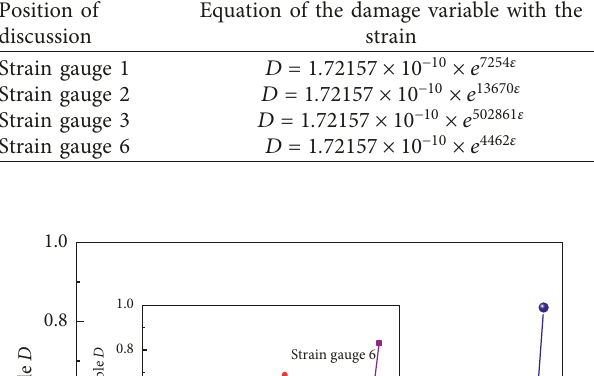
Table 3: Basic physical parameter values of the limestone. Table 4: Equation of the damage variable with the strain. Position of discussion